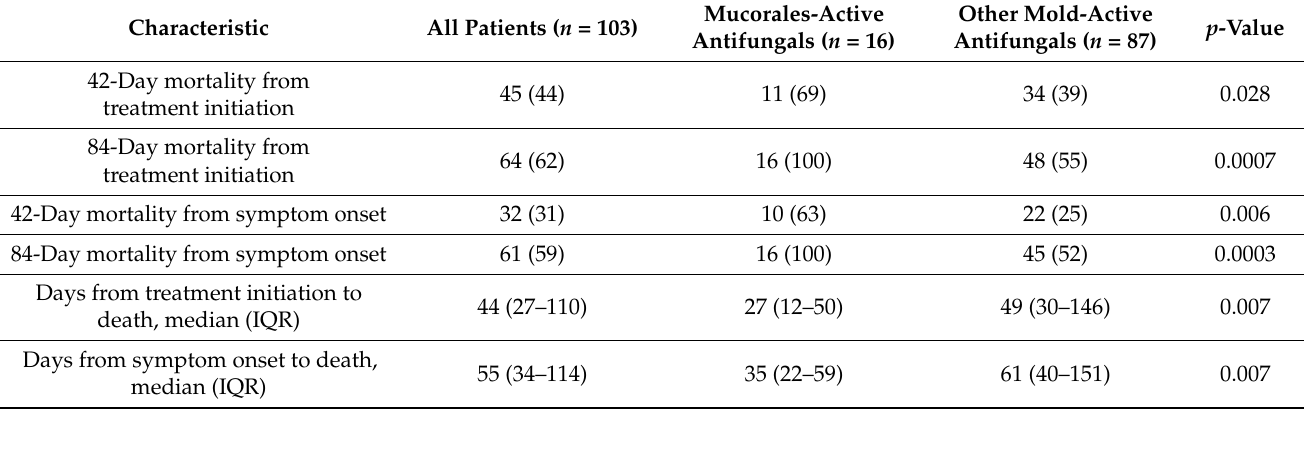
univariate analysis.